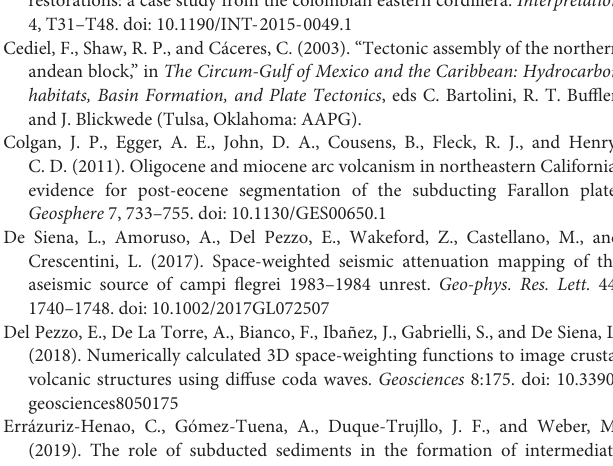
DATA SHEET S1 | MatLab R (cid:13) figure format showing different views of the isotherms 730 ◦ C (blue), 780 ◦ C (yellow), and 830 ◦ C (red). The reader may rotate, zoom for detailing features, and overlay other information to the model using MatLab. DATA SHEET S2 | MatLab R (cid:13) data file with results of the tomographic inversion and isotherms distribution. This file contains the following variables: F, W, and M correspond to polygons of regional faults, country boundaries, and spring water occurrences, respectively. MatrizI, MatrizR, and WS, contain the spatial matrix of attenuation anomalies, RDE, and NEB, respectively (see Figure 5 ). XV, YV, and ZV are the spatial coordinates of the 3D cube analyzed. Tsoft550_a_020 is the 3D matrix with the estimated isotherms. vac and vin, represent the coordinates of active and inactive volcanoes in the study area. VIDEO S1 | Video showing different views of the isotherms 730 ◦ C (blue), 780 ◦ C (yellow), and 830 ◦ C (red). The isotherms have anomalously high values on